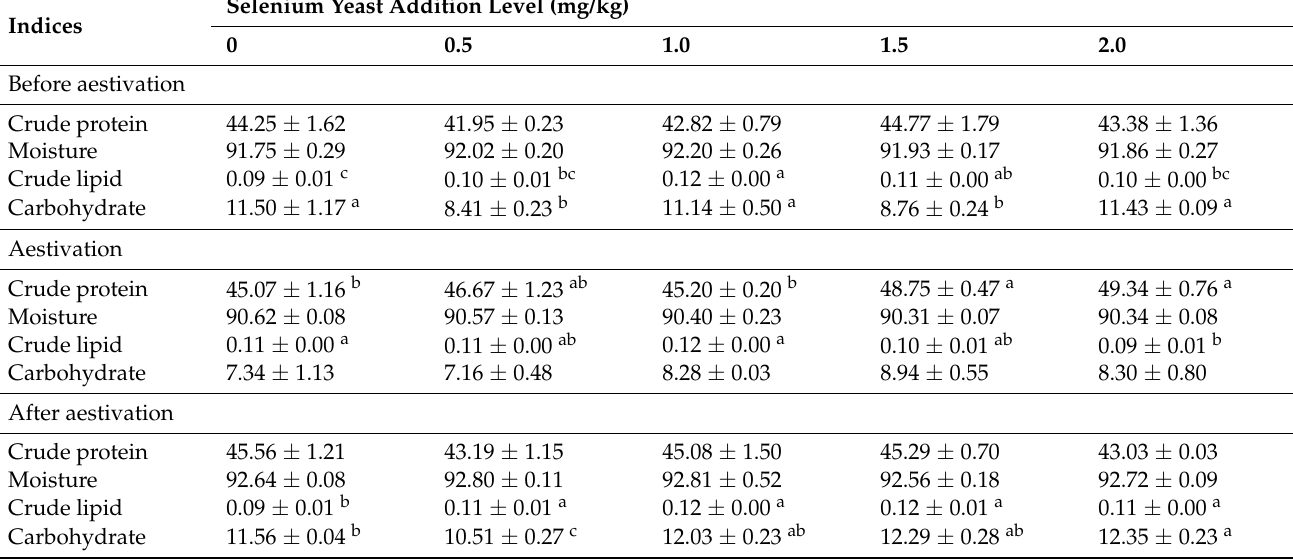
Table 6. Effects of selenium yeast addition on the proximate composition in the body wall of juvenile sea cucumber ( Apostichopus japonicus ) before and after aestivation (means ± SE, n = 3).